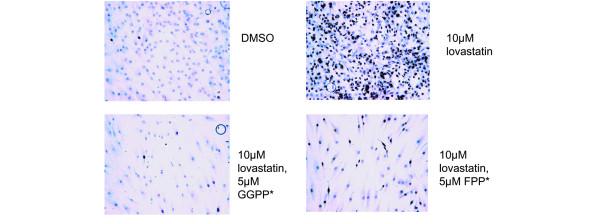
TUNEL assay confirms the presence of DNA fragments in synovial fibroblasts treated with lovastatin. DNA fragments in synovial fibroblasts treated or not with 10 μM lovastatin for 72 hours were detected by a TdT-FragEL DNA fragmentation kit. After TdT-mediated dUTP nick end labelling (TUNEL) staining, cells were counterstained with hematoxylin. TUNEL-positive cells have dark nuclear staining, whereas the nuclei of TUNEL negative cells stain blue. Asterisk, 5 μM geranylgeranylpyrophosphate (GGPP) or 5 μM farnesylpyrophosphate (FPP) were included with the lovastatin.